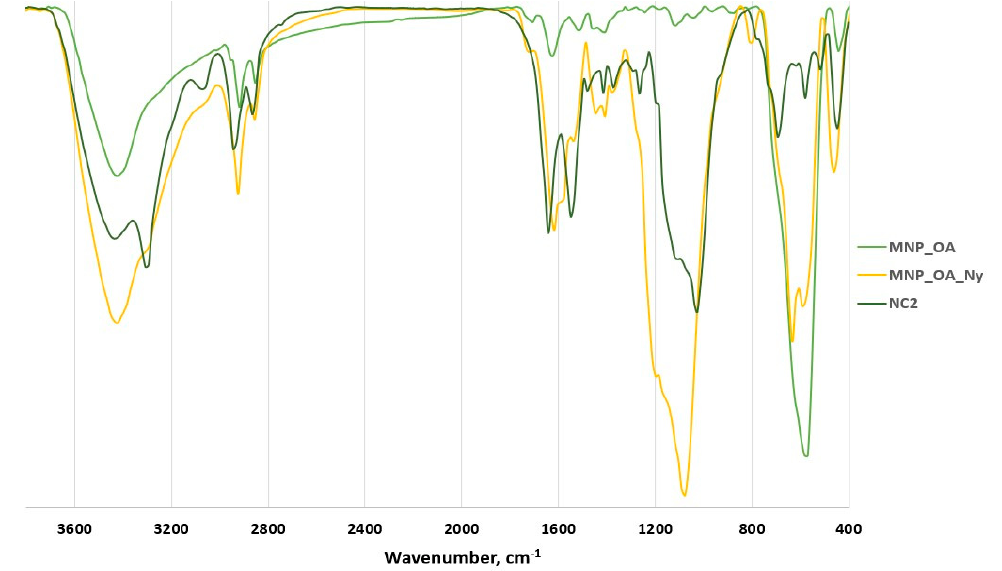
Figure 3. FT-IR spectra of MNP_OA, MNP_OA_Ny, and NC2 composites.